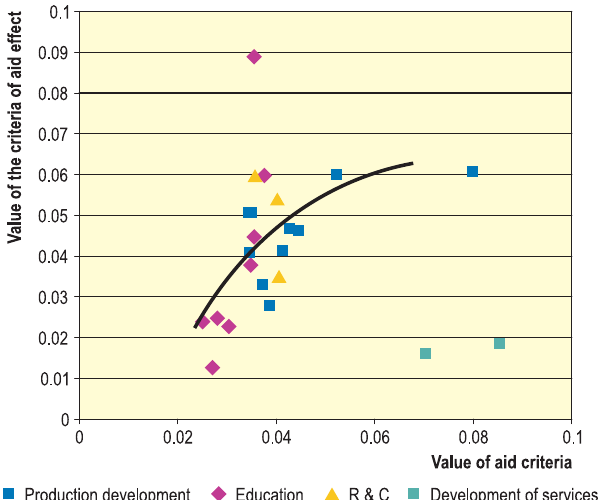
Fig. 3. The effect of aid to enterprises according to the areas of their activities calculated by VS (correlation coeffi cient –